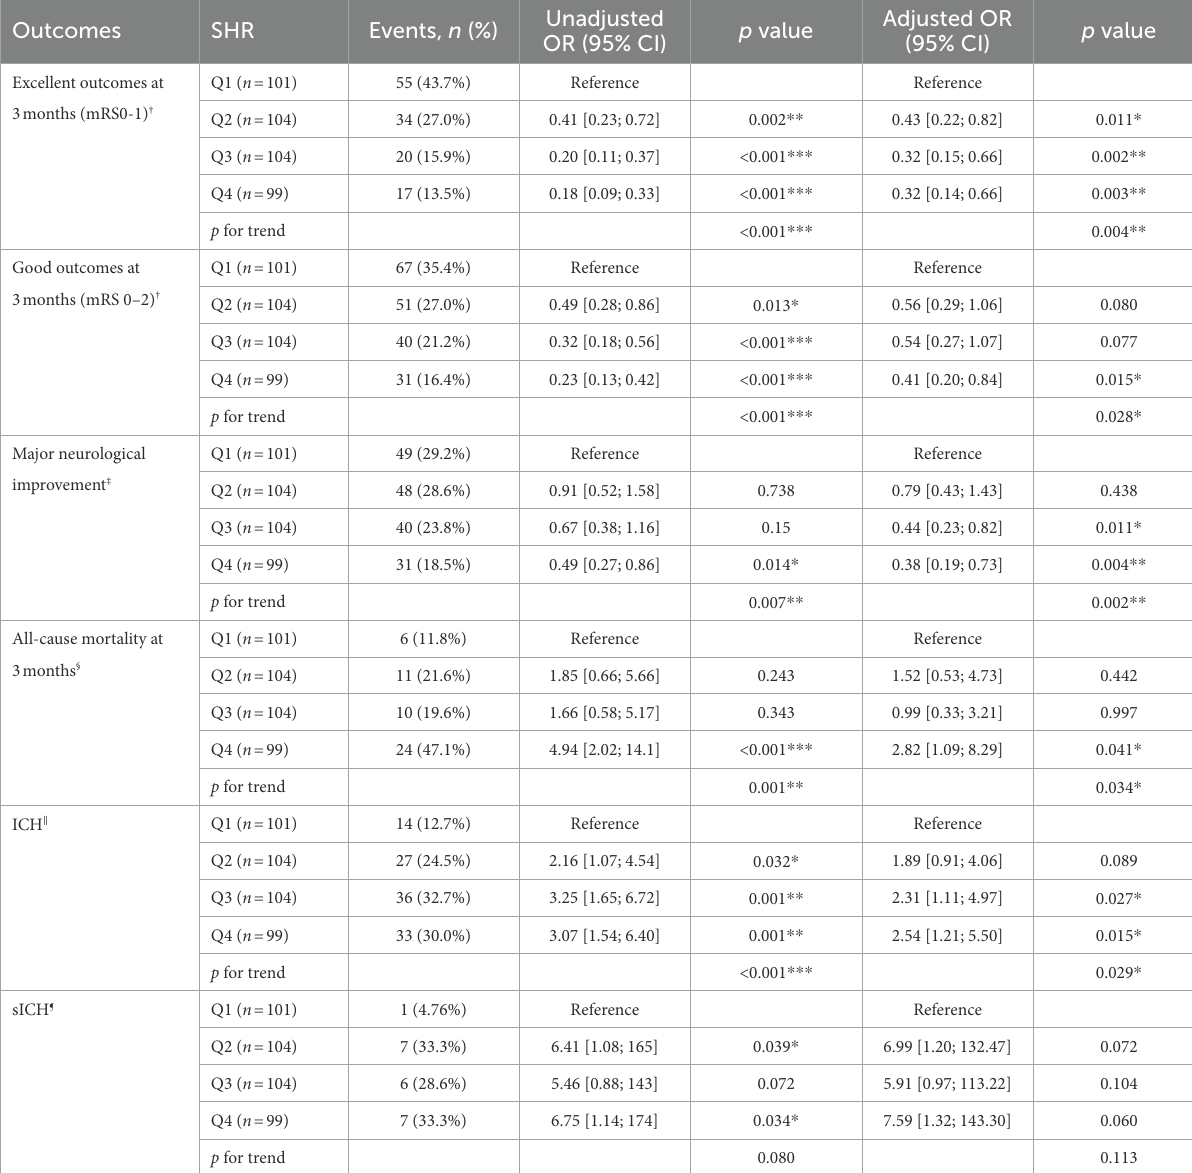
TABLE 2 Association between SHR and